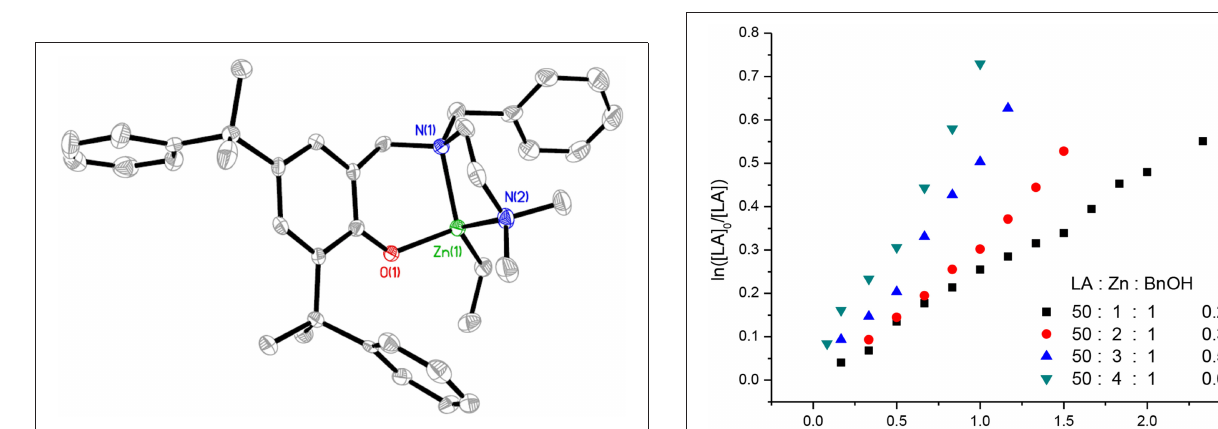
FIGURE 3 | Molecular structure of L 1 ZnEt (ellipsoids drawn at the 50% probability, H atoms omitted for clarity). Selected bond lengths (Å) and angles